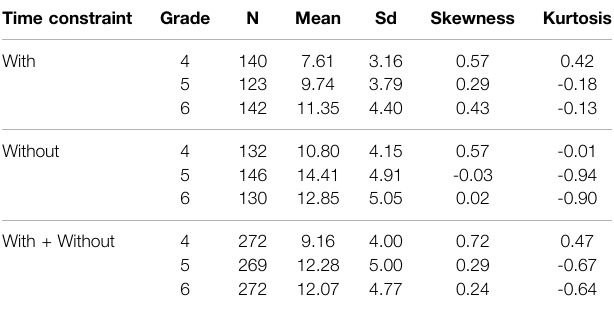
TABLE 4 | Descriptive statistics of test